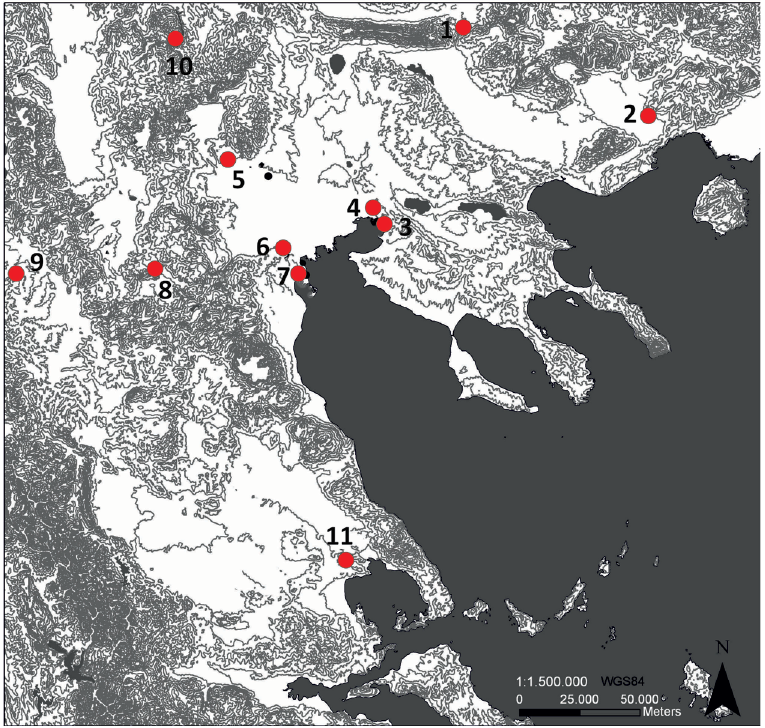
Figure 1. Map of Northern Greece showing the locations of sites mentioned in the text: 1. Promachon-Topolniça, 2. Dikili Tash, 3. Thermi, 4. Stavroupoli, 5. Mandalo, 6. Paliambela, 7. Makriyalos, 8. Kleitos, 9. Avgi Kastorias, 10. Polyplatano Imathias, 11.